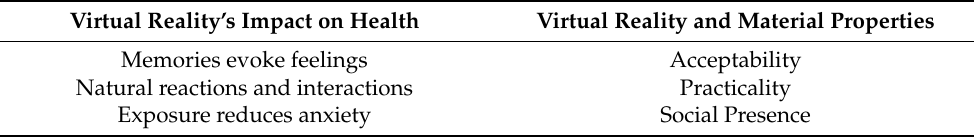
Table 3. People with mild cognitive impairment and dementia